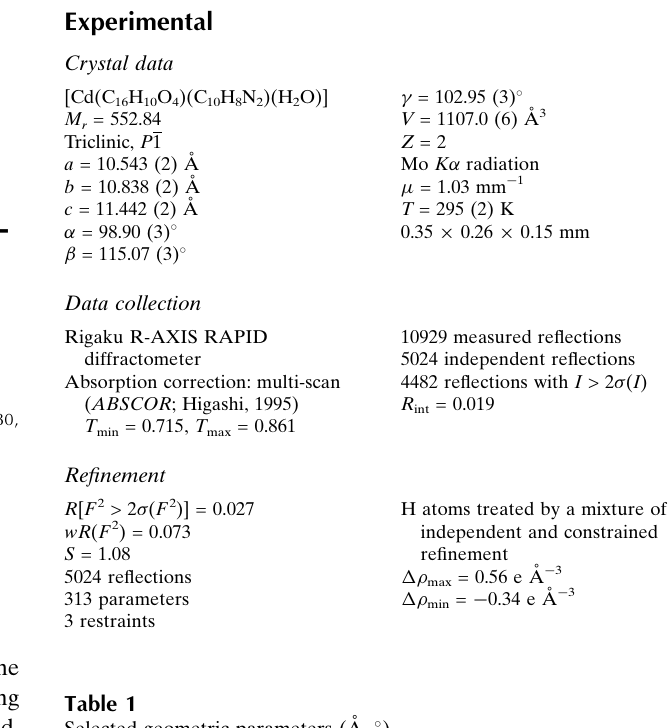
Selected geometric parameters (A˚ , (cid:2) ).